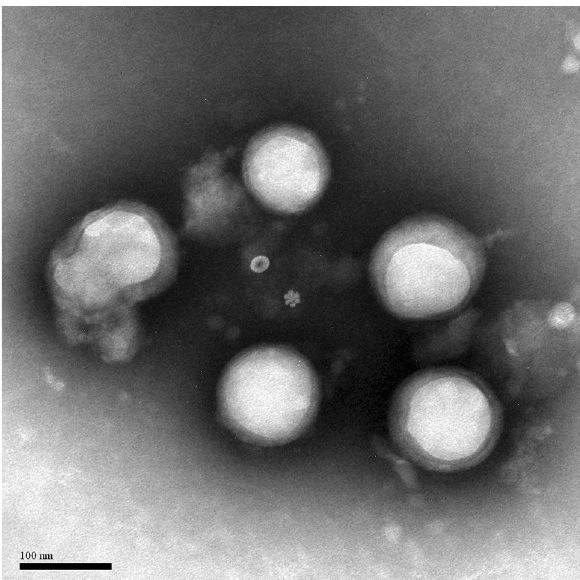
Figure 2. TEM images of F-pHSM-L61/CUR/DOX.